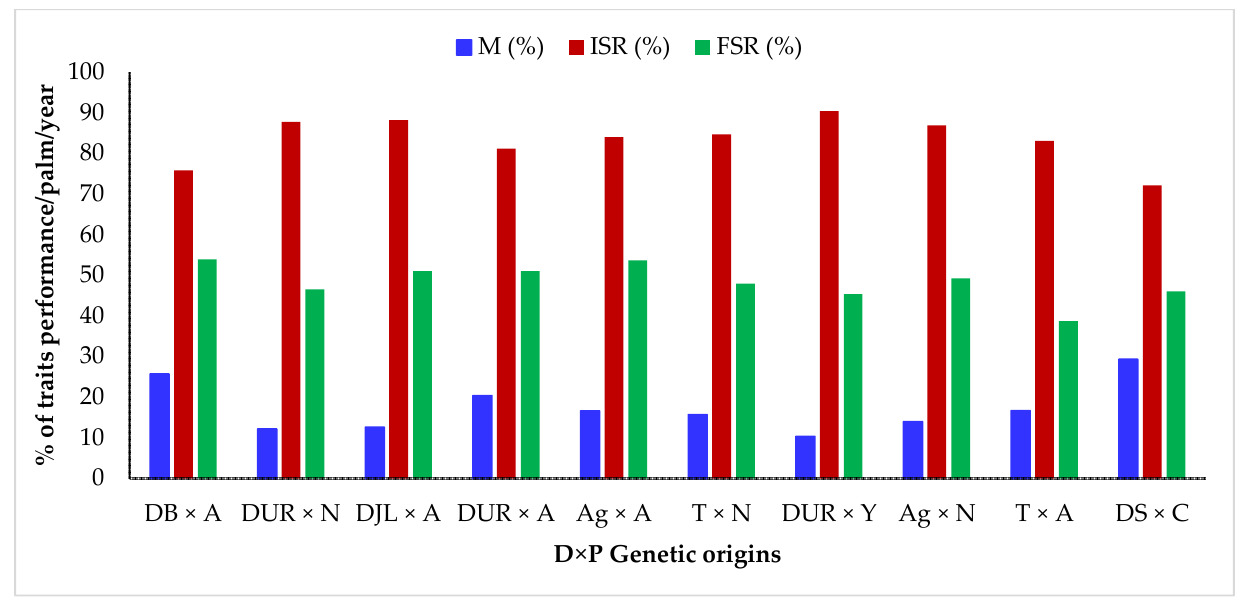
Figure 2. Parental mean performance per palm per year for key component traits. M, male flower (%); FSR, fruit set ratio (%); ISR, sex ratio (%); Ag, Angola; A, AVROS (Algemene Vereniging rubber planters); N, Nigeria; C, Cameroon; DJL, Deli Johor Labis; DUR, Deli Ulu Remis; T, Tanzania; Y, Yangambi; DB, Deli Banting.